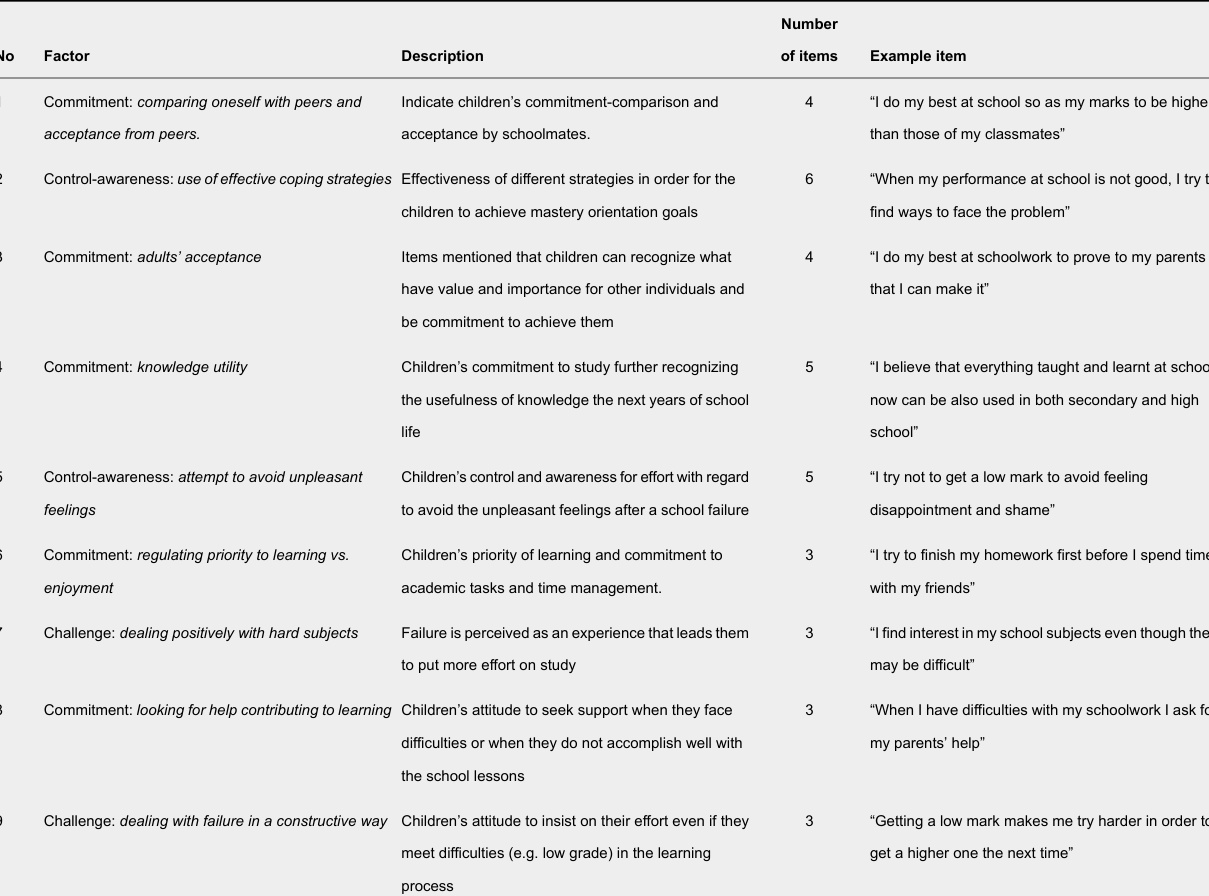
Factors of the “Dimensions of Academic Hardiness Questionnaire” for Late Elementary School Children, Description, Number of Items and Example